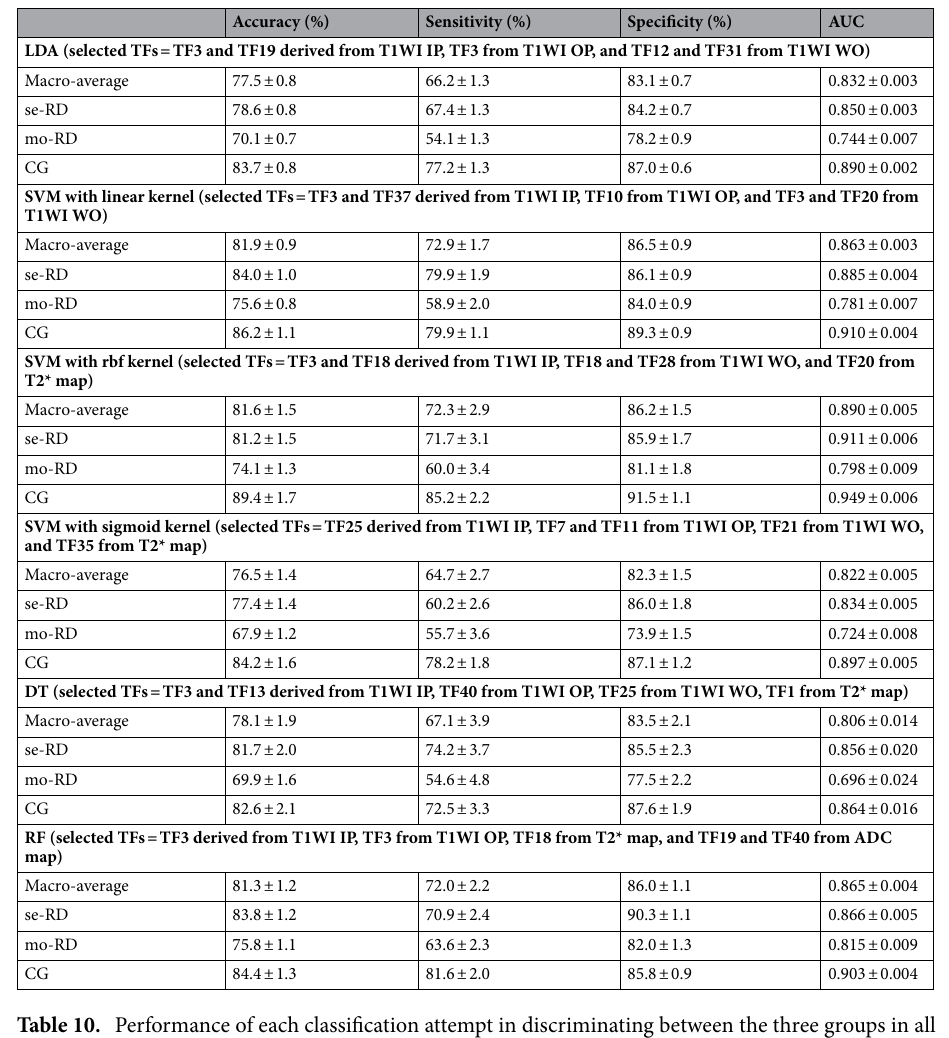
DWI with multiple b-factors, and T2*WI with multiple gradient-echoes obtained in the coronal plane. For the Dixon-based T1WI, only IP/OP/WO images were used in the analysis, as other images (such as fat-only images and fat fraction ratio maps) were not generated in all patients. The ADC map was automatically generated based on a monoexponential fitting model using DWI at the four b-factors. In BOLD, 12 T2* WIs corresponding to 12 different gradient echoes were acquired. T2* maps were generated on a pixel-by-pixel basis by fitting a linear regression method through the logarithms of the signal intensities versus their 12 echo times. Table 11 presents the representative MRI scanning sequences and parameters. Data analysis procedures. Figure 4 presents the data analysis workflow. After segmentation, image processing, texture feature extraction, and reproducibility analysis were performed for each imaging method (T1-weighted IP/OP/WO images, ADC map, and T2* map), followed by texture feature selection and ML-based model construction in separate classification attempts. The combinations of the texture features were also exam-